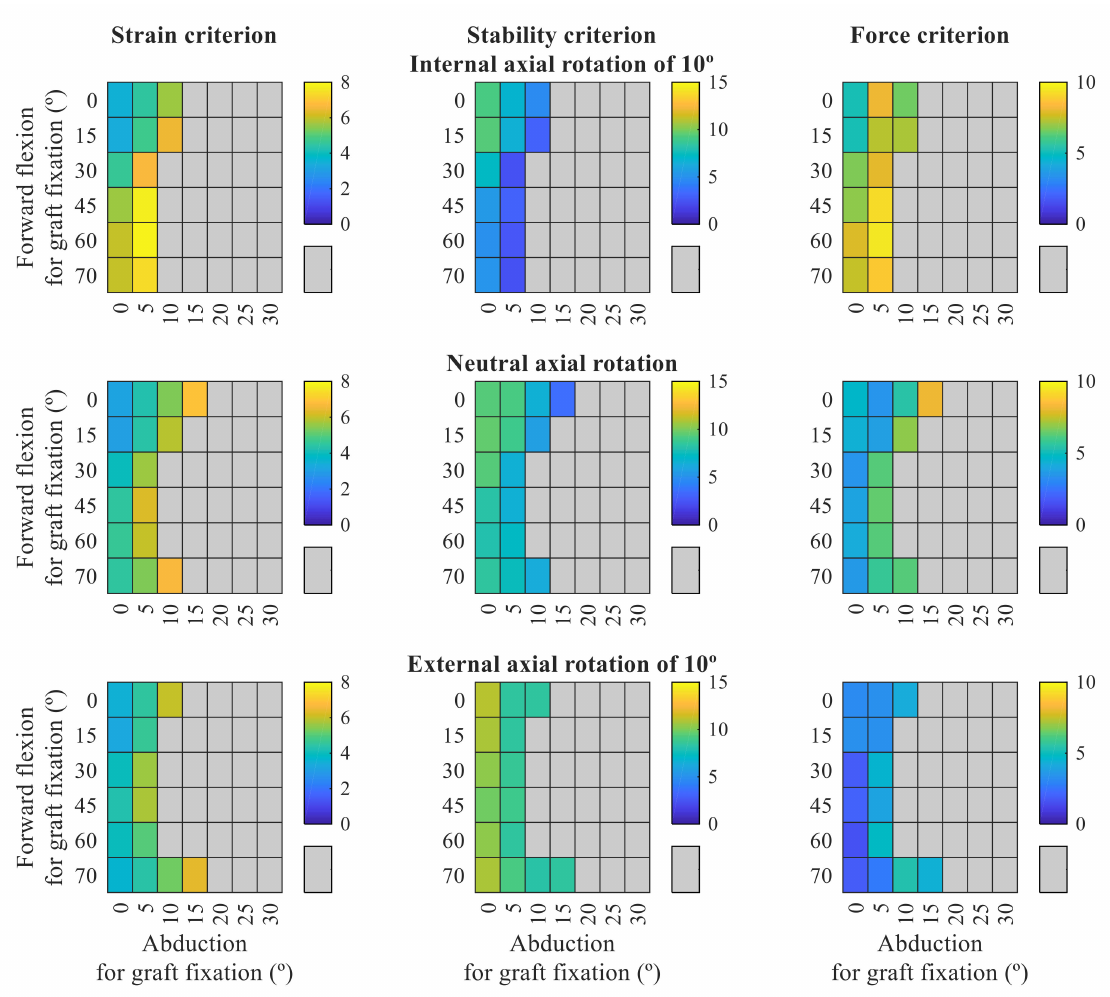
Figure 4. Heatmaps of the strain, stability, and force criteria for the shoulder condition (4), with implanted graft and a full-thickness tear of the supraspinatus. The risk of failure increases as the strain criterion approaches 15%. Stability and force criteria values closer to 0% mean that the graft can better restore the stability of the shoulder joint to its healthy condition. The grey color represents the shoulder positions of fixation that failed the screening